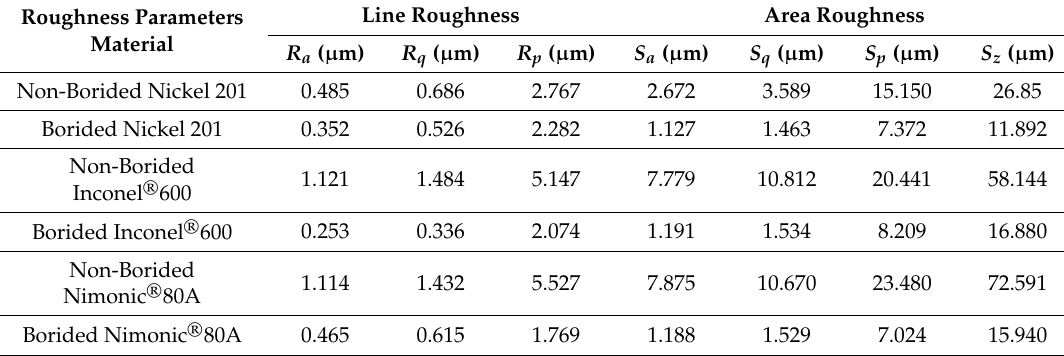
Table 3. Roughness parameters of corroded surfaces after the corrosion resistance